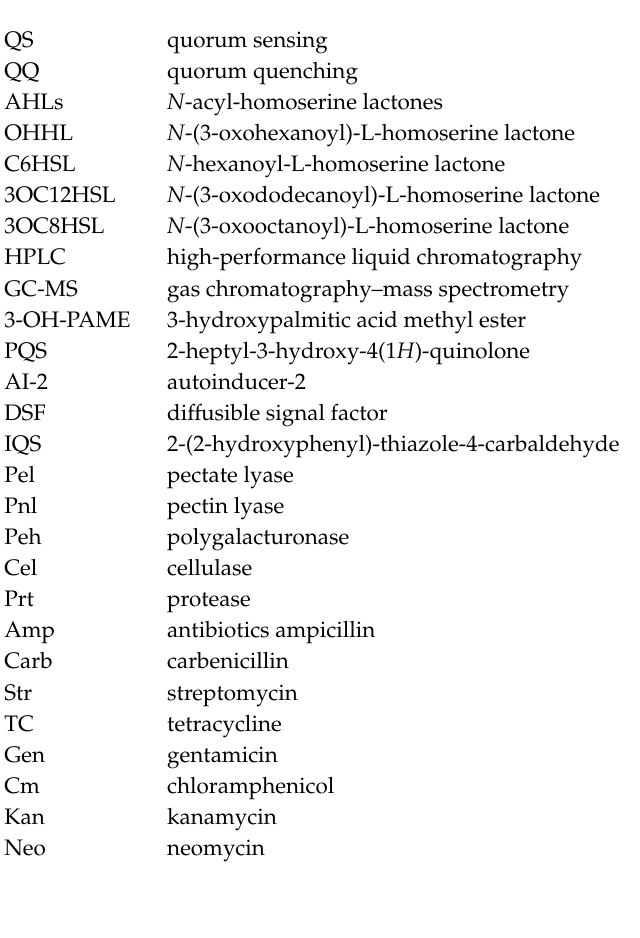
Figure S1: Morphological characteristics of strain XN-10. (a) Colony morphology of strain XN-10. (b) Scanning electron micrograph of strain XN-10. Figure S2. The residual amount of OHHL at di ff erent times detected by HPLC. Panel A is MSM with OHHL alone as a control group; Panels B, C, D, E, and F are the remaining OHHL after utilization by strain XN-10 at 0, 1, 2, 3, and 4 days, respectively. Figure S3: Full scan mass spectrum of the AHL degradation products by strain XN-10. a: 12 h; b: 24 h. A: Compound A; B: Compound B; C: Compound C. Figure S4: Mass spectra of AHL degradation products by strain XN-10. (a) AHL; (b) N -Cyclohexyl-propanamide; and (c) Pentanoic acid, 4-methyl, methyl ester. Figure S5: Mass spectra of degradation products of AHL by strain XN-10 in the NIST library database. A: AHL; B: N -Cyclohexyl-propanamide; and C: Pentanoic acid, 4-methyl, methyl